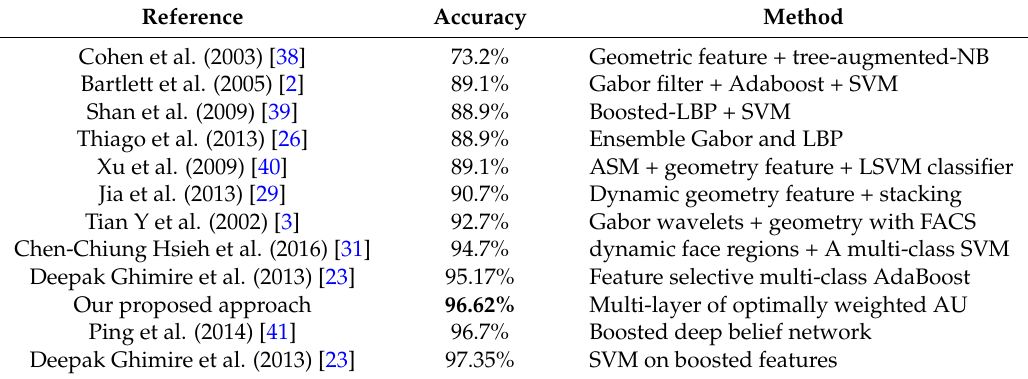
Table 11. Comparison with existing methods on CK database.